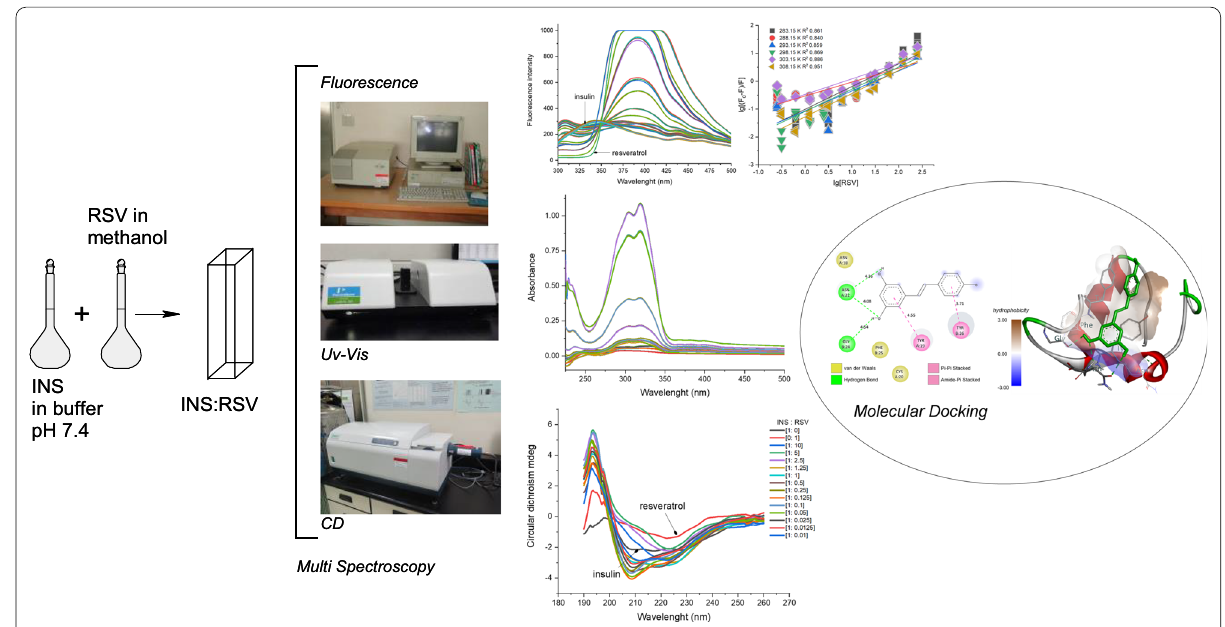
Fig. 2 Flowchart of profiling insulin–resveratrol